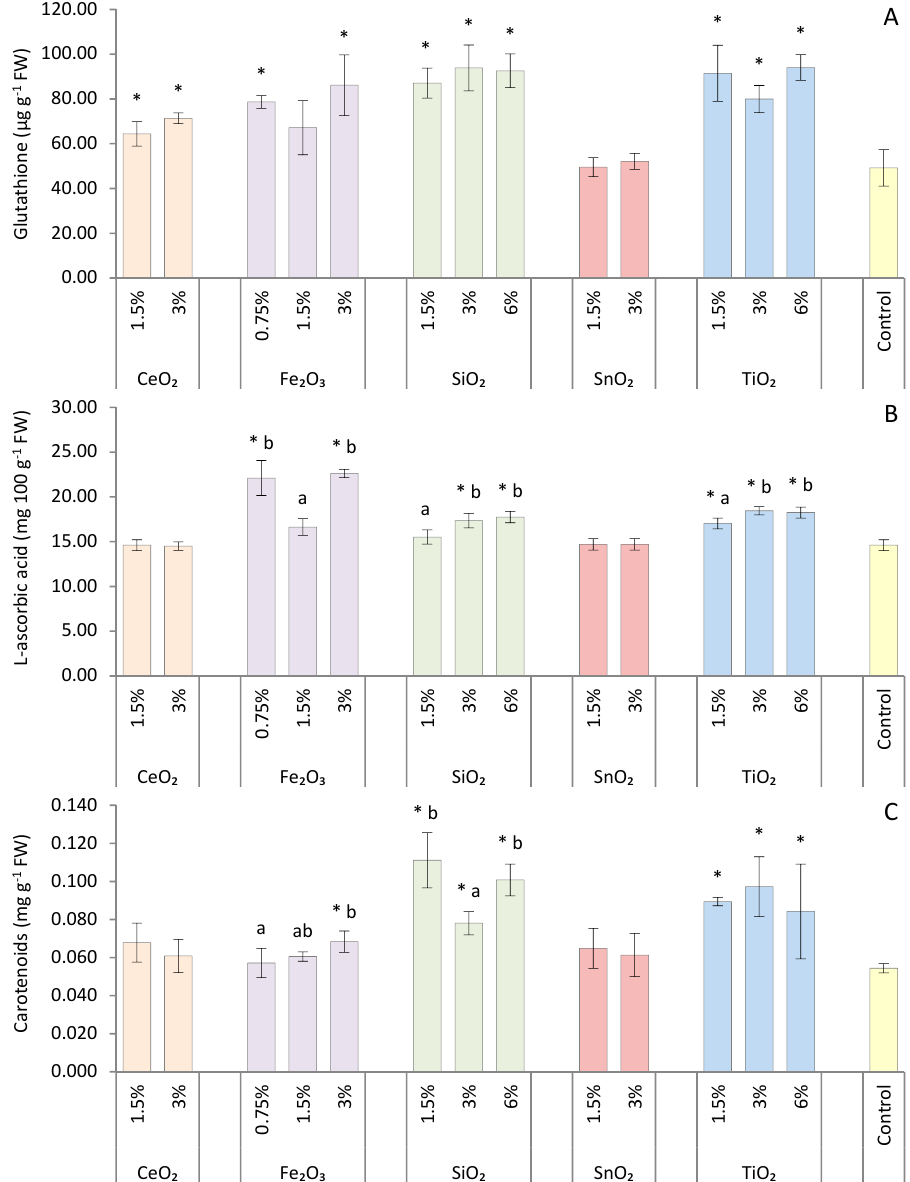
Figure 2. Content of glutathione ( A ), L-ascorbic acid ( B ), and carotenoids ( C ) in oakleaf lettuce seedlings treated with engineered nanoparticles (nano-metal/metalloid oxides; MO-NPs) applied to the leaves at different concentrations. Control plants were sprayed with deionized water. *Denotes significant differences between particular treatments and unexposed control, comparisons were performed by Fisher test ( p ≤ 0.05). Means ( n = 3) for concentrations of given MO-NPs followed by different letters are significantly different at p ≤ 0.05 according to Fisher test. Bars represent standard deviations (± SD).